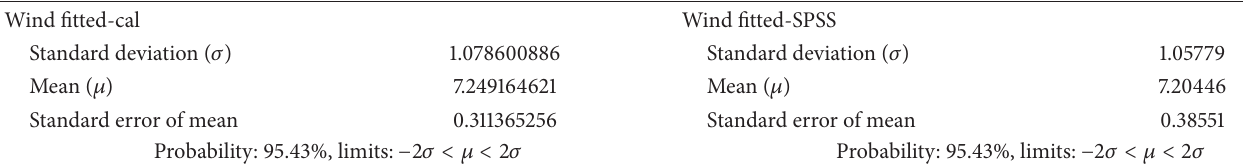
Table 5: The standard deviation, mean, standard error of mean, probability, and limits of regression equation results for a dependent variable wind speed.